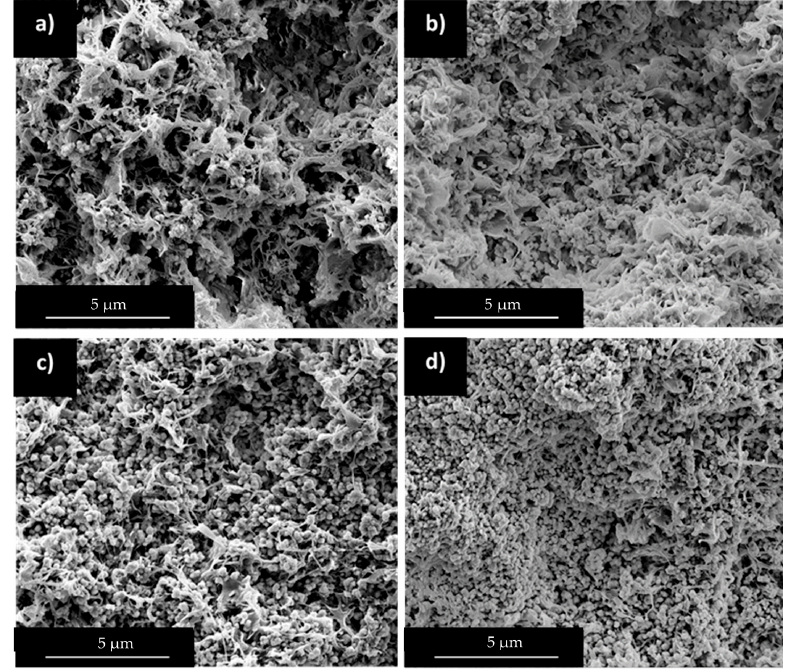
Figure 10. SEM observations after waxes solvent extraction (HDPE/PP ratio of 70/30), with increasing solid loadings of zirconia particles: ( a ) 10 vol%, ( b ) 20 vol%, ( c ) 30 vol%, and ( d ) 40 vol%.